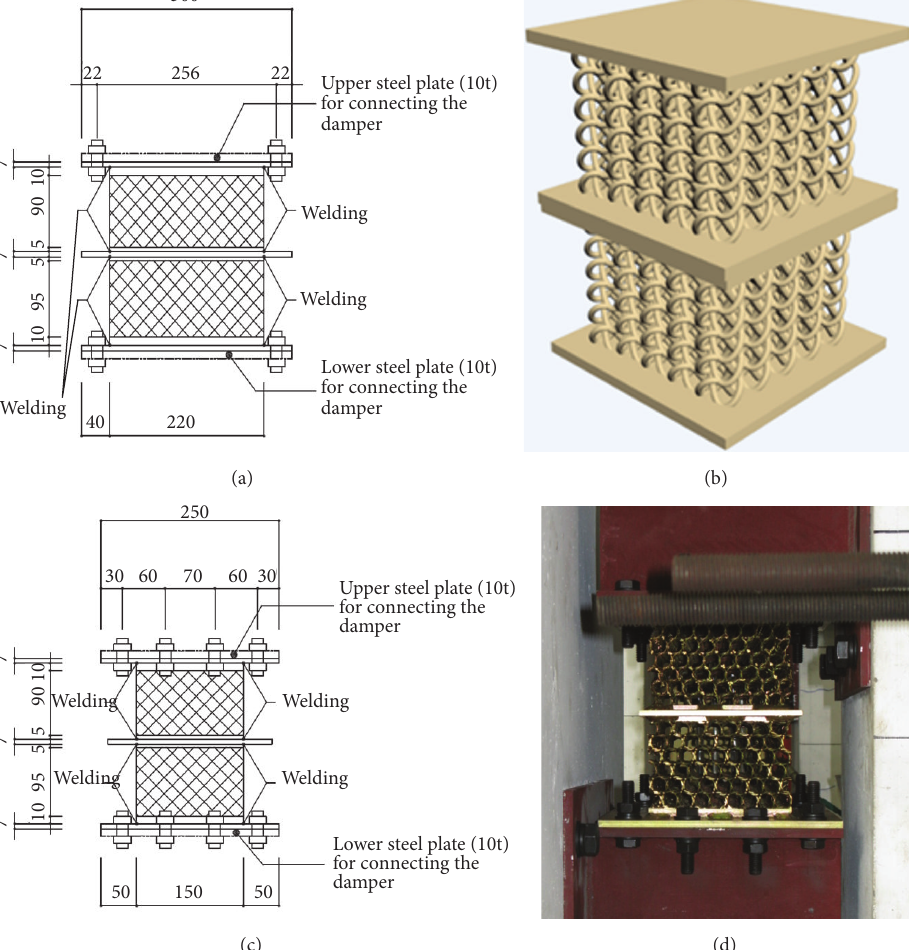
Figure 6: Configuration and details of the Kagome damper: (a) front view, (b) isometric view, and (c) side view. (d) Fabrication of the Kagome